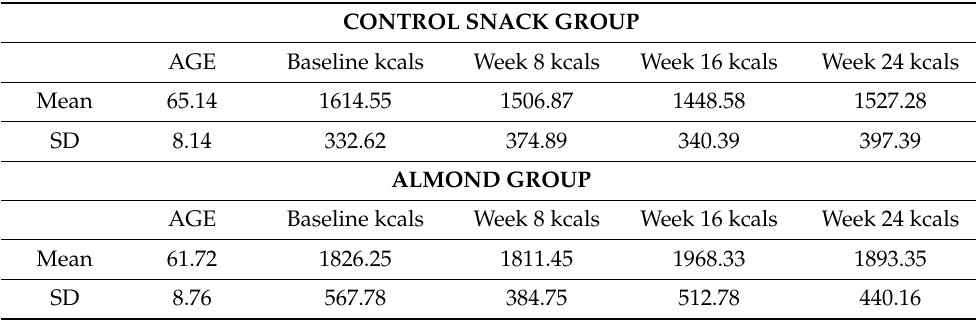
Table 1. Mean and standard deviation (SD) of age and caloric intake (in kilocalories) of participants in the control and almond group at each visit.